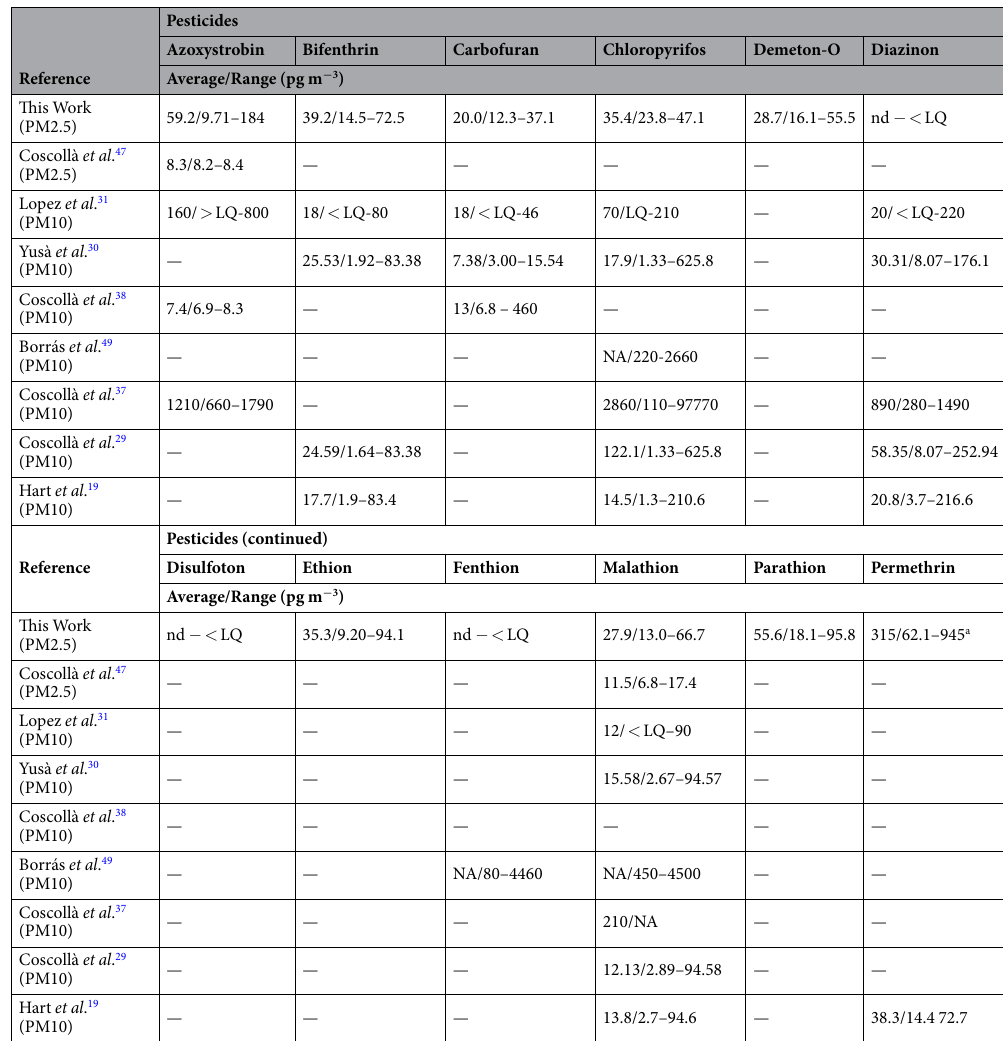
Table 5. Comparison of pesticide concentrations found in this work with recent studies. a Sum of the permethrin I and permethrin II isomers. NA: Data not available. nd: not